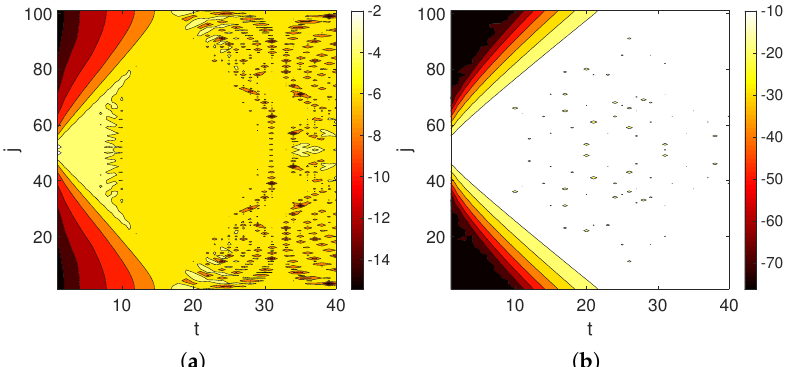
Figure 3. Plot of the transition probability π 50, j for a quantum particle located at t = 0 at position 51 of a ring having 101 nodes. ( a ) quantum transport controlled by the Schrödinger equation with d -path Laplacian L s = 2 ; ( b ) quantum transport controlled by the Schrödinger equation without LRI L s → ∞ . The values of π 50, j are given in logarithmic scale for better visualization. The colobar corresponds to the transition probability in logarithmic scale.